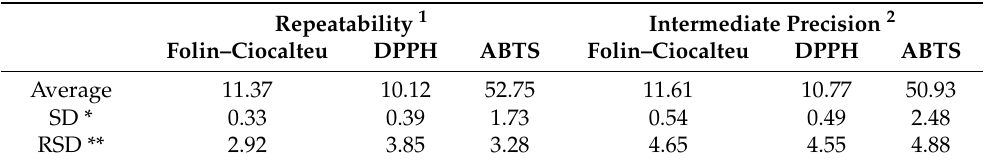
Table 4. Repeatability and intermediate precision of the global optimal conditions established in the study with regard to total phenolic compounds content and antioxidant capacity of the extracts obtained by UAE from mushroom